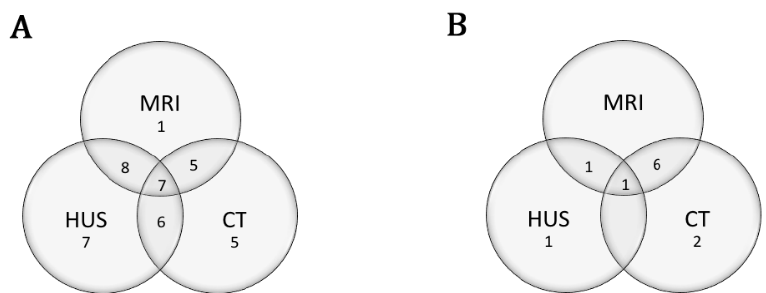
Figure 2. Neuroimaging types for patients in early group. Areas of intersection correspond with patients who had multiple neuroimaging modalities. The number represented in each area represents the number of patients ( n ) who received each type of the adjacent neuroimaging. ( A ) Neuroimaging in patients who received VA ECMO, n = 39 ( B ) Neuroimaging in patients who received VV ECMO, n = 11 VA: veno-arterial; VV: veno-venous; ECMO: extracorporeal membrane oxygenation. MRI: